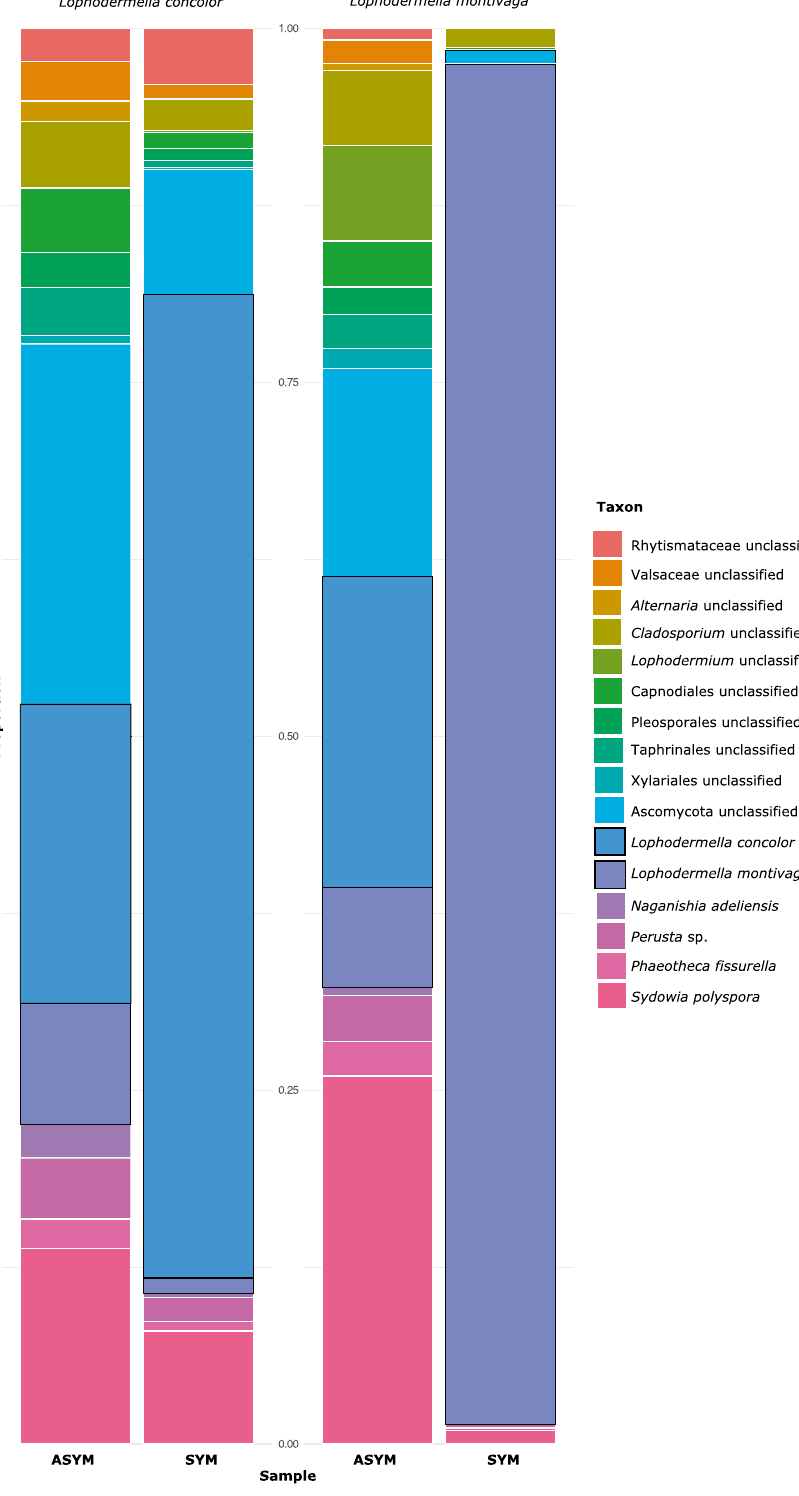
Figure 1. Relative abundance of fungal taxa (removing OTUs assigned as unclassified fungi) within the mycobiome across Pinus contorta needles that were asymptomatic (ASYM) and symptomatic (SYM) of Lophodermella concolor and L. montivaga identified through